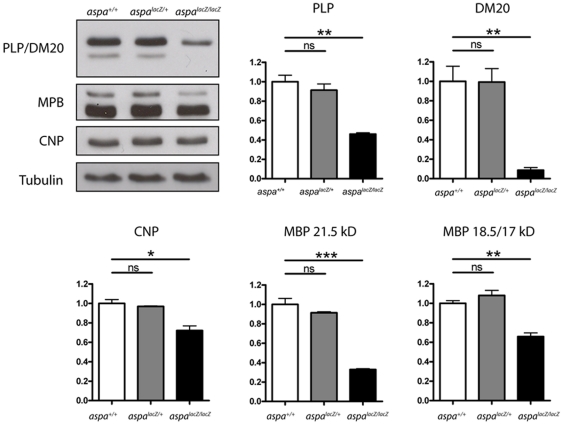
Myelin protein levels are reduced in aspalacZ/lacZ mutants.Western blot analysis of PLP, DM20, CNP and MBP levels in whole brain lysates of aspa+/+, aspalacZ/+ and aspalacZ/lacZ mice (P60, n = 3). Quantification of immunoblots shows statistically significant decreases of all proteins tested in homozygous mutants while the presence of one functional aspa allele is sufficient to preserve protein quantities at control levels. Note: PLP, DM20, and the MBP21.5 kD and MBP18.5/17 kD isoforms were analysed separately.